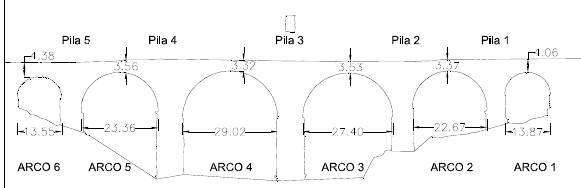
Figure 2. Longitudinal section of the bridge of